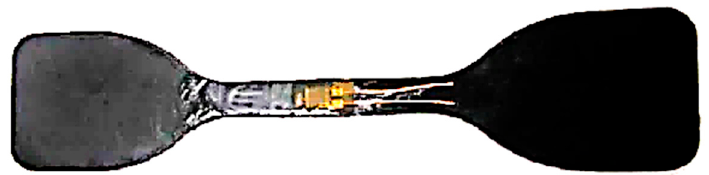
Figure 8. Tensile specimen with strain gage attached.